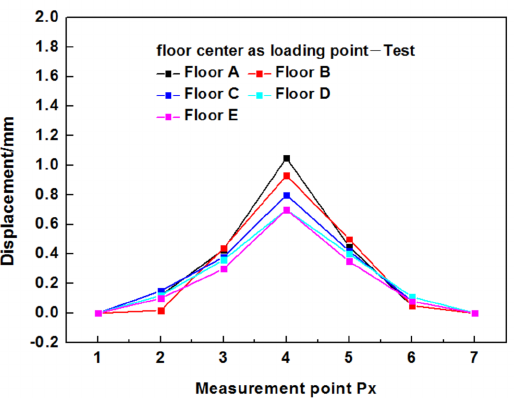
Figure 14. Experimental deflections at measurement point when floor center as loading point.